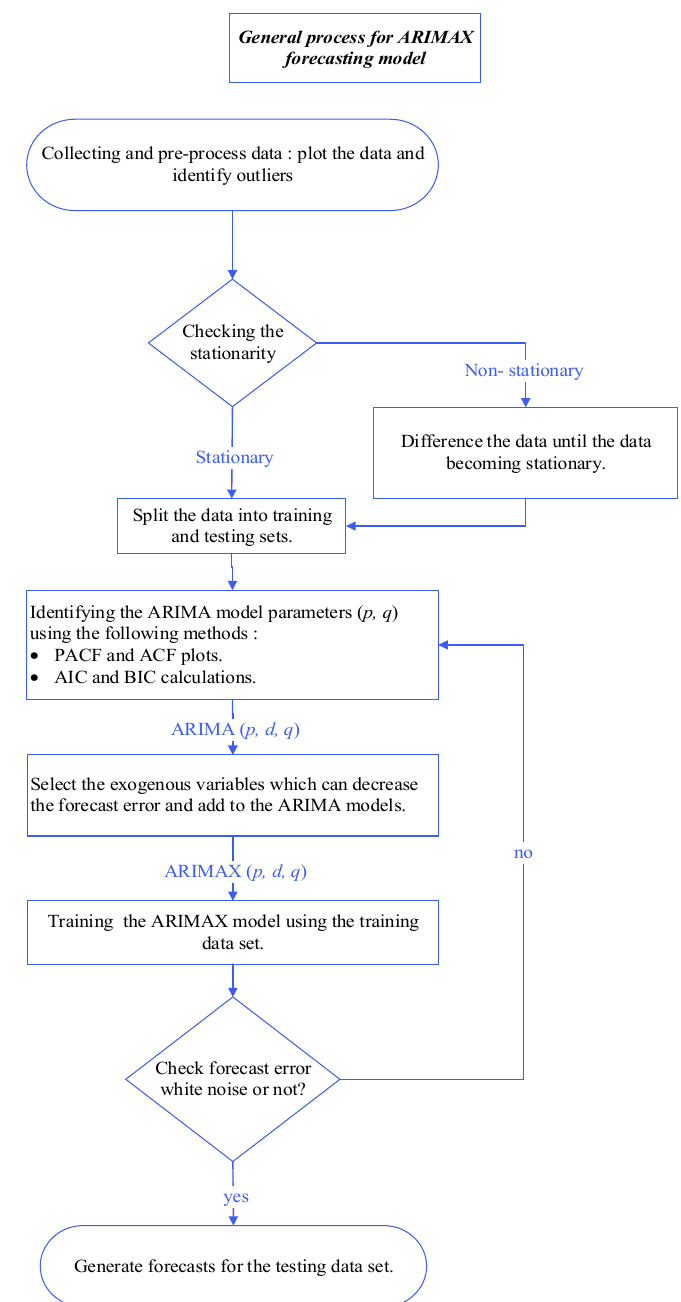
Figure 16. Methodology of the Autoregressive Integrated Moving Average (ARIMA) and ARIMAX forecasting